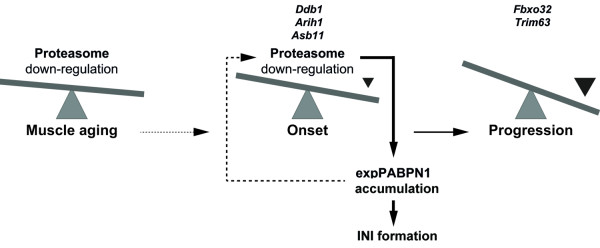
A model for the involvement of UPS in OPMD disease pathology. In muscle, age-associated proteasome down-regulation affects expPABPN1 protein accumulation. Elevated expPABPN1 accumulation affects proteasome deregulation during disease onset. Expression profiles of E3-ligases can be sued to separate disease onset from progression.